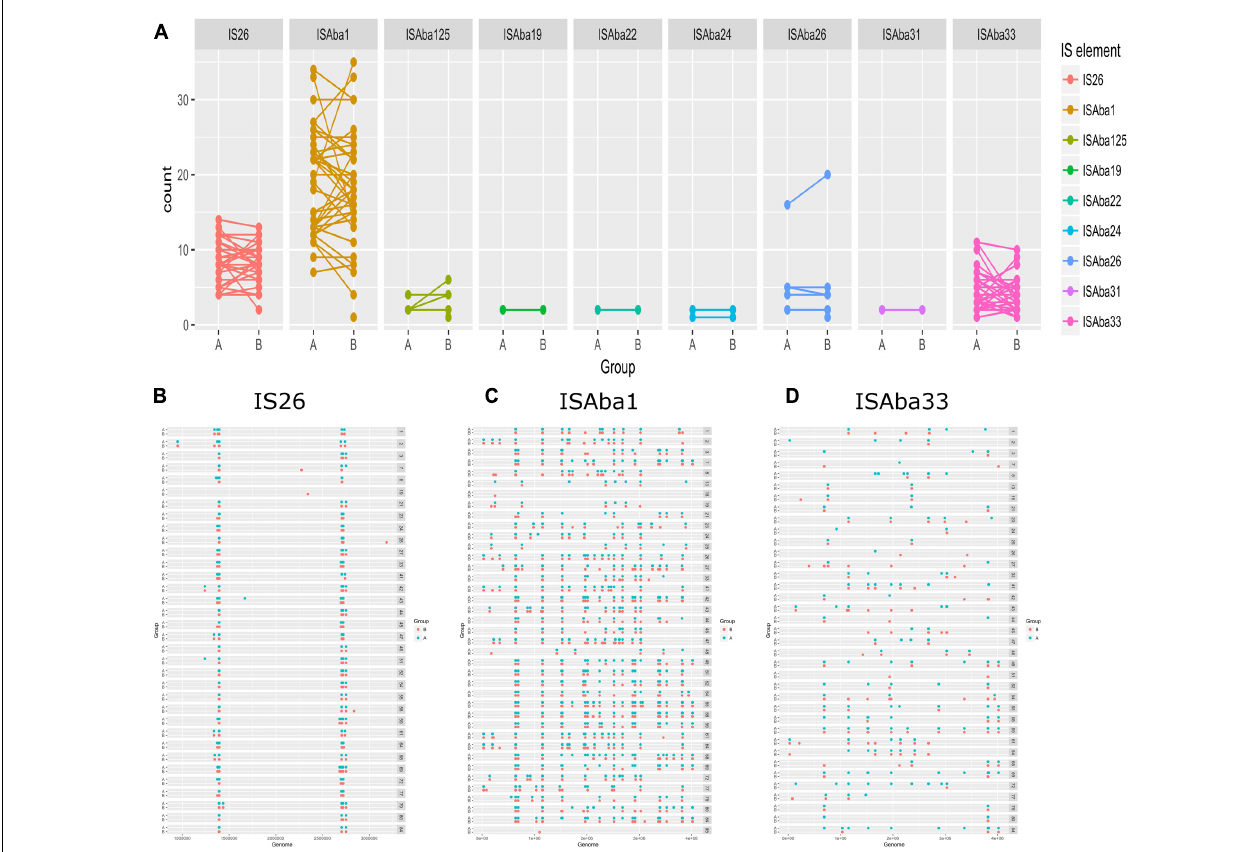
FIGURE 6 | The distribution of IS elements in Groups A and B in A. baumannii . (A) The copy number of IS elements in Groups A and B. The position of IS26 (B) , ISAba1 (C) , ISAba33 (D) in Group A and Group B.